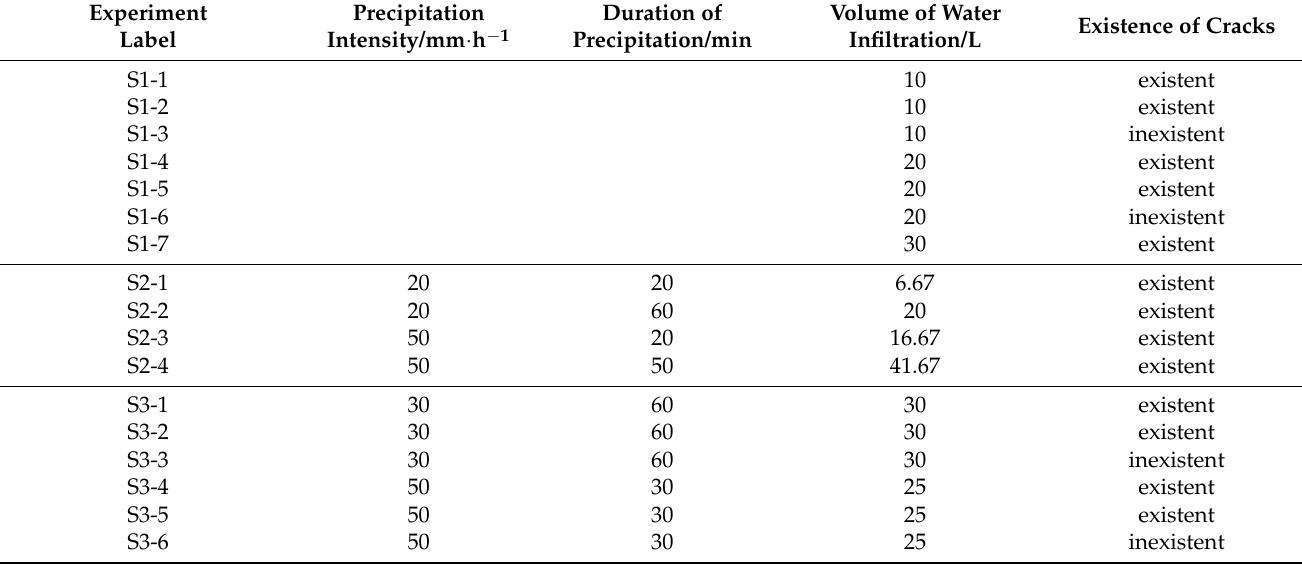
Table 2. Experimental conditions of the